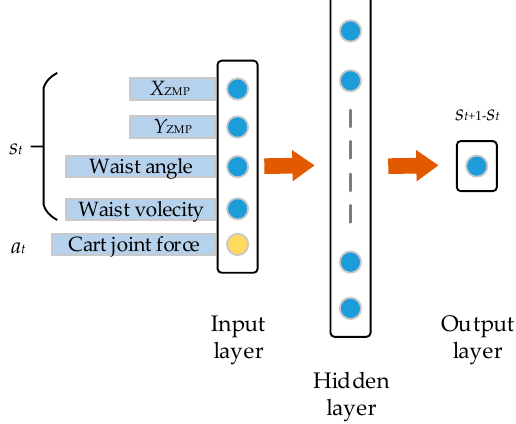
Figure 6. Neural network structure.